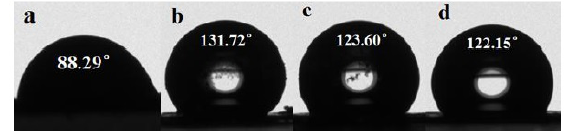
Figure 6: The water contact angles of the materials PRs (a), HPRs (b), HPRs-1: HPRs after one recycling experiment (c), HPRs-5 : HPRs after five recycling experiments (d)